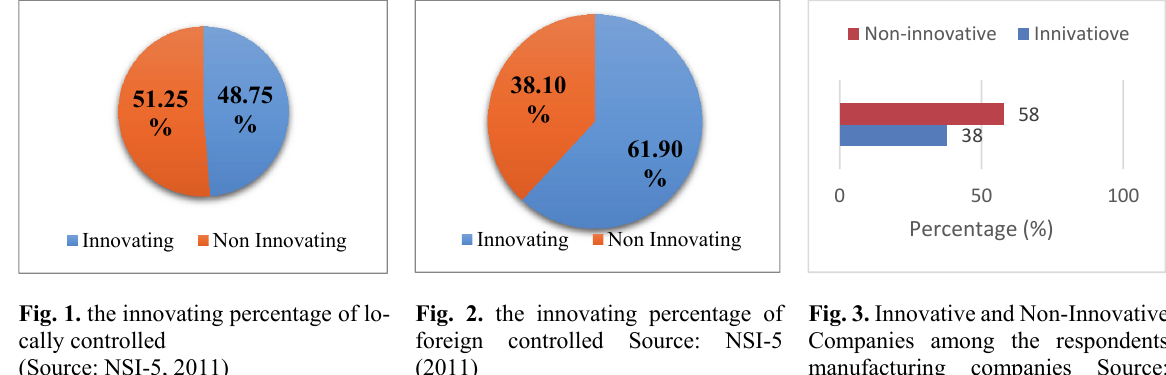
Fig. 1. the innovating percentage of lo- cally controlled (Source: NSI-5, 2011)